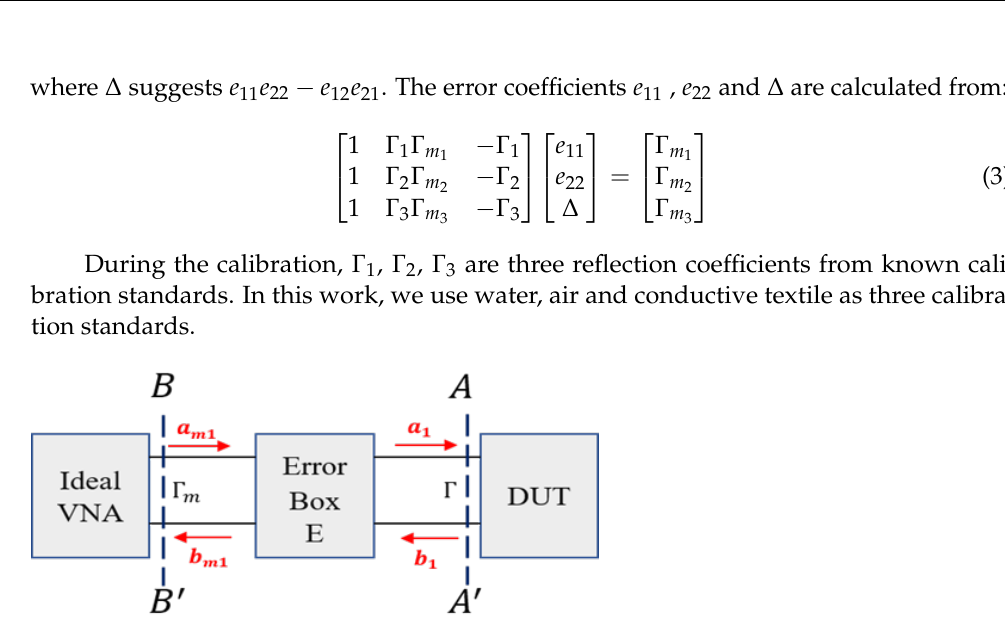
Figure 2. One-port error box, which includes both unwanted effects by the probes and the instru- ment’s systematic